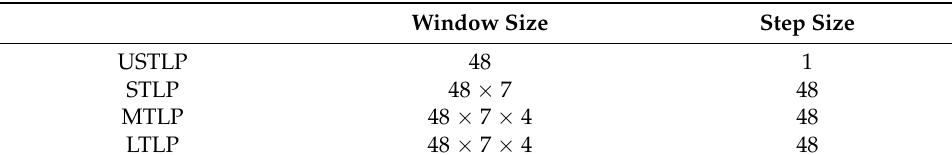
Table 2. Rolling window technique parameters for both algorithms.